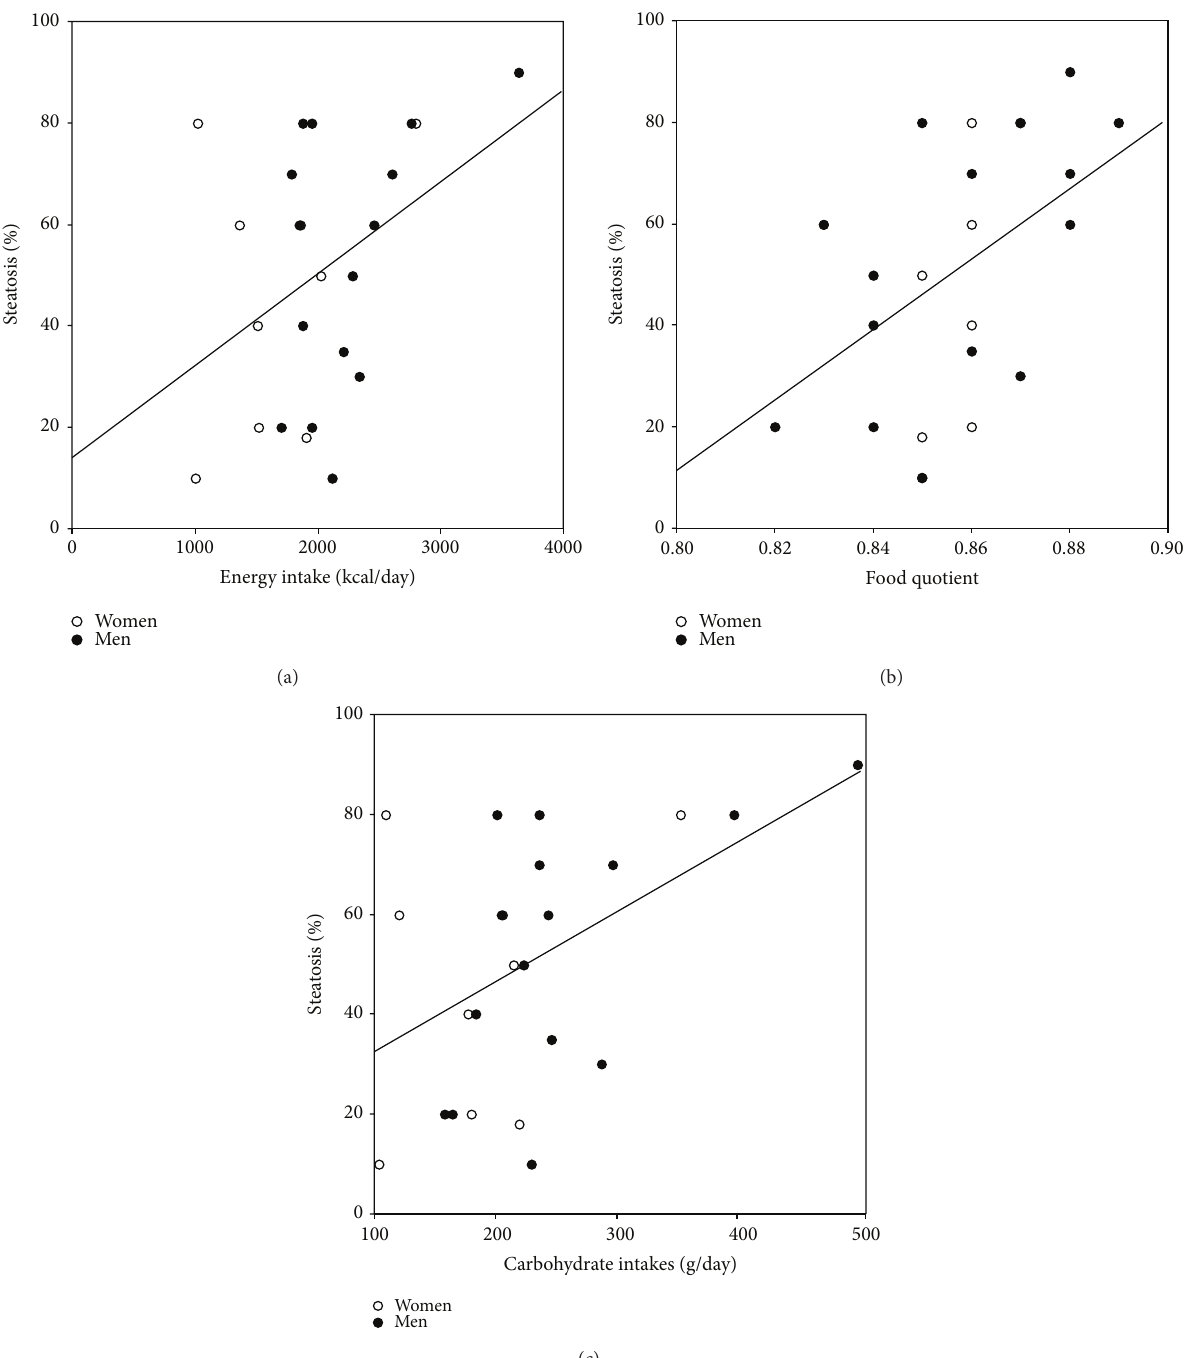
Figure 1: Steatosis% ( 𝑦 -axis) as a function of the energy intakes ( 𝑥 -axis, (a)), food quotients ( 𝑥 -axis, (b)), and carbohydrate intakes ( 𝑥 -axis, (c)) in 24 patients with NAFLD (women—open circles, men—closed